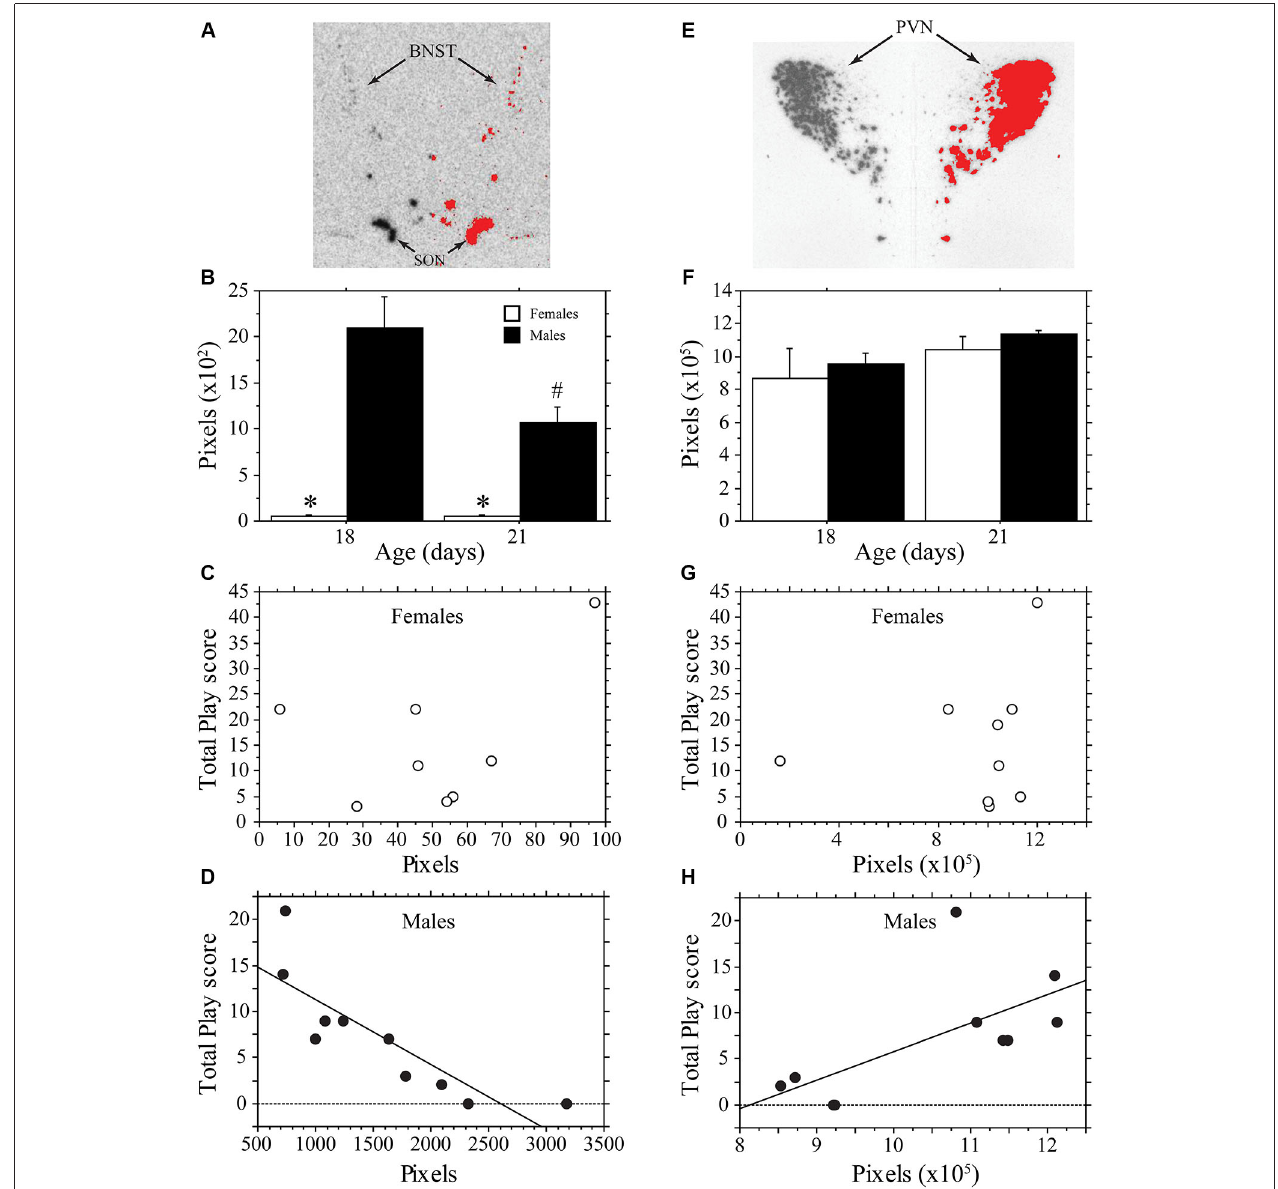
rats. Panels C, D, G, and H illustrate the correlational analysis of Total Play behavior and AVP mRNA in the BNST (C, D) and PVN (E, H) . Note the significant negative correlation with the BNST of males (D) , the significant positive correlation with the PVN of males (H) , and the absence of a significant correlations in females (C, G) . * indicates significant sex difference within age group; # indicates significant decrease in AVP mRNA of 21-day-old males from 18-day-old